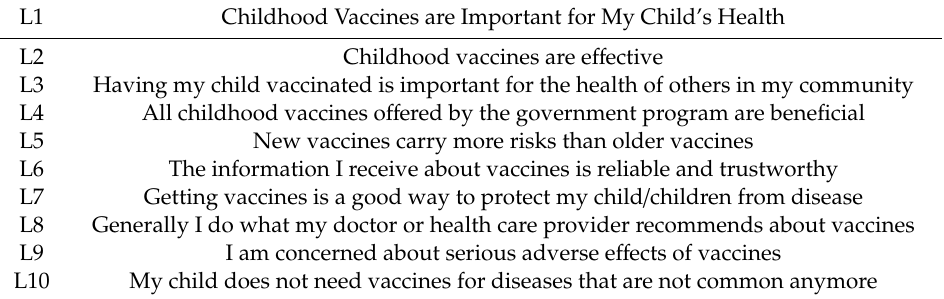
Table 2. The correlation across items was assessed using a Pearson’s correlation coe ffi cient. Table 2. Vaccine hesitancy questions from World Health Organization (WHO) Strategic Advisory Group of Experts (SAGE) on immunization working